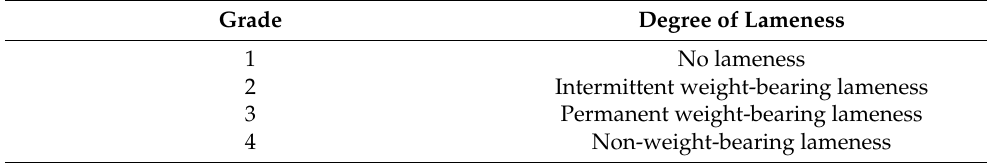
Table 1. Lameness evaluation system.